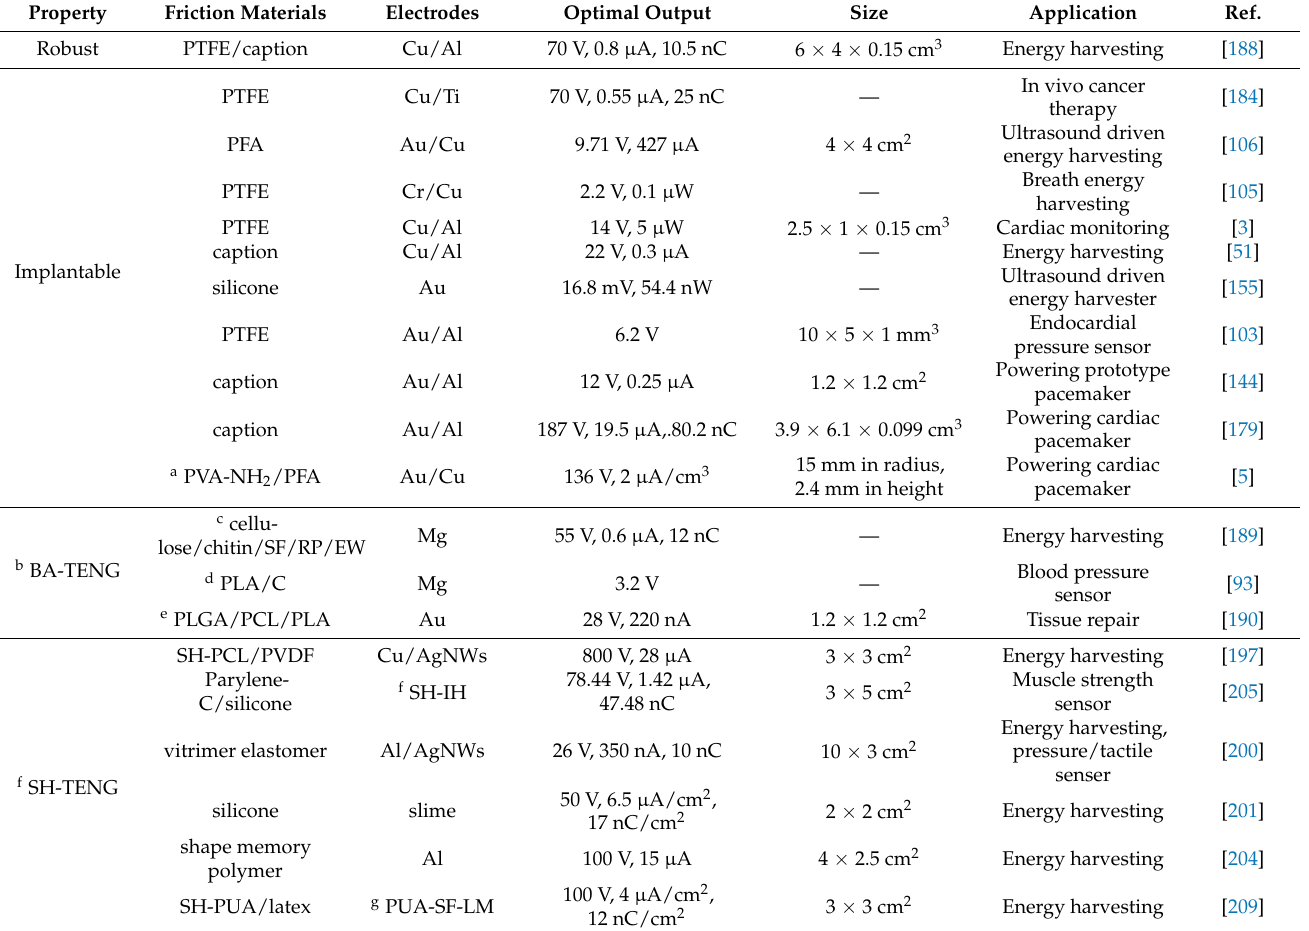
Table 2. Performance comparison of TENGs with different triboelectric